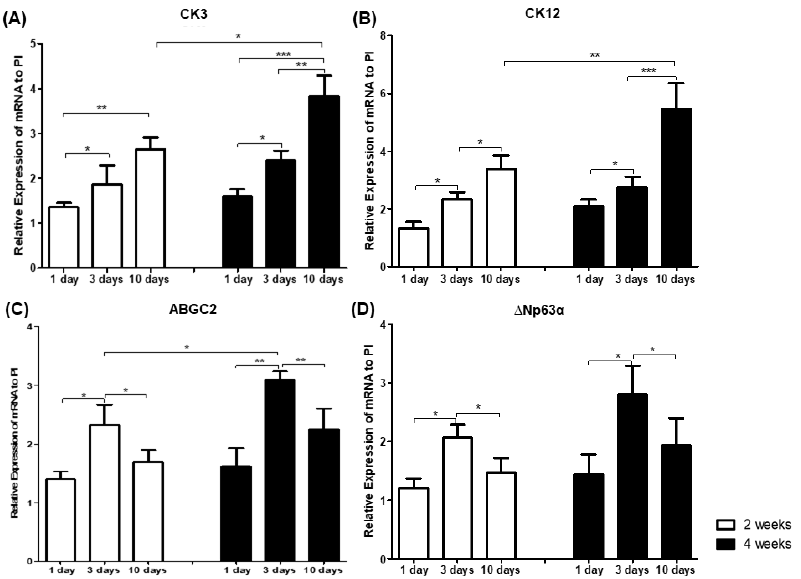
Figure 2. Analysis of gene expression analysis for corneal epithelium markers ( A , B ) and limbal progenitor-related markers ( C , D ) in human iPS cells grown in a limbal cell culture system with varying durations of BMP4 administration. Human iPS cells were cultured in a limbal-specific medium (PI) with 10 ng/mL BMP4 during the first 1, 3, or 10 days of culture. Data represent 3 or 4 independent experiments and are presented as means ± standard deviation (* p < 0.05; ** p < 0.001; *** p < 0.001). Human iPS cells (Figure 3A,B) exhibited the typical morphology of iPS cells: round colonies of flat, dense cells with scant cytoplasm and prominent nucleoli [18]. Partially differentiated human iPS cells cultured in PI medium alone were heterogeneous popula- tions of large, ovoid, fusiform cells (Figure 3C). However, human iPS cells cultured with PI medium with 10 ng/mL BMP4 for the first 3 days exhibited a limbal cell-like morphol- ogy: small, cuboidal, compact, cobblestone-like, regularly arranged cells that were more homogeneous than those grown in PI medium alone at 4 weeks (Figure 3D) [19].